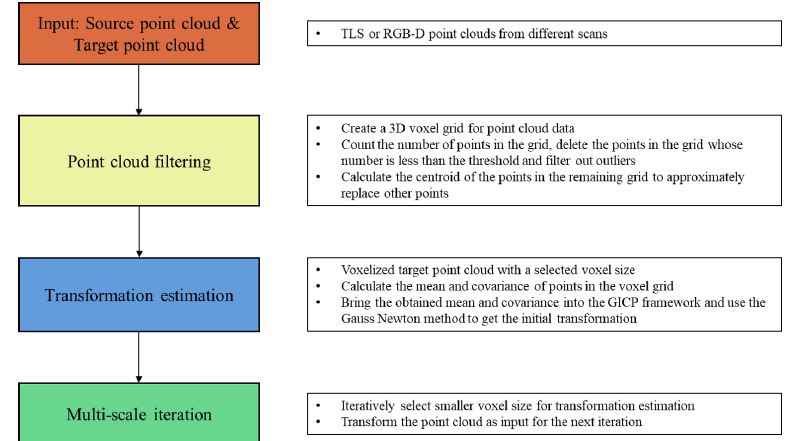
Figure 1. Flowchart of the proposed registration algorithm for a 3D point